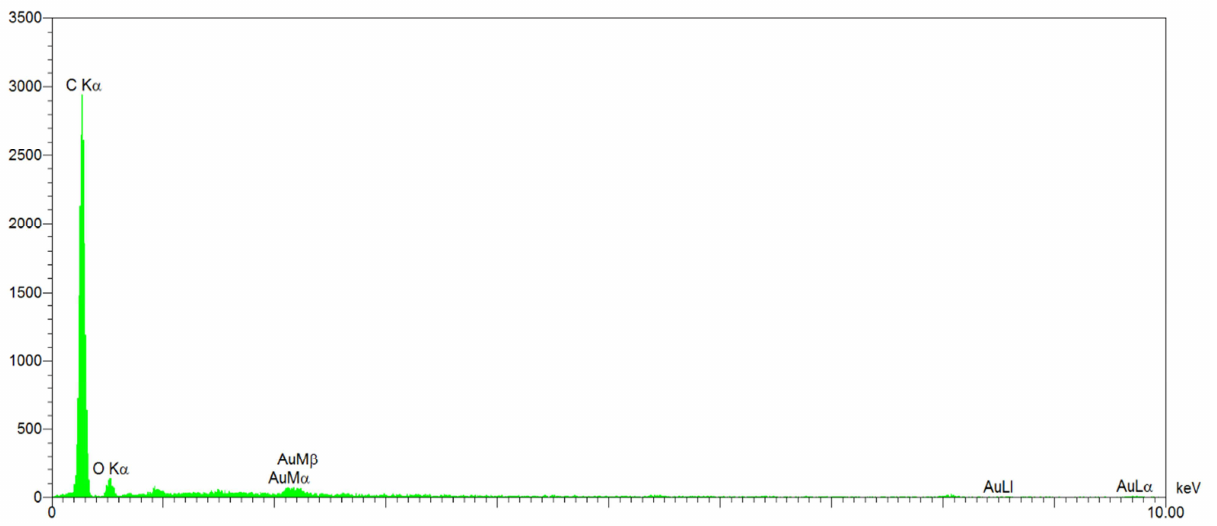
Figure 2. Energy-dispersive X-ray spectroscopy (EDS) diagrams of activated carbon